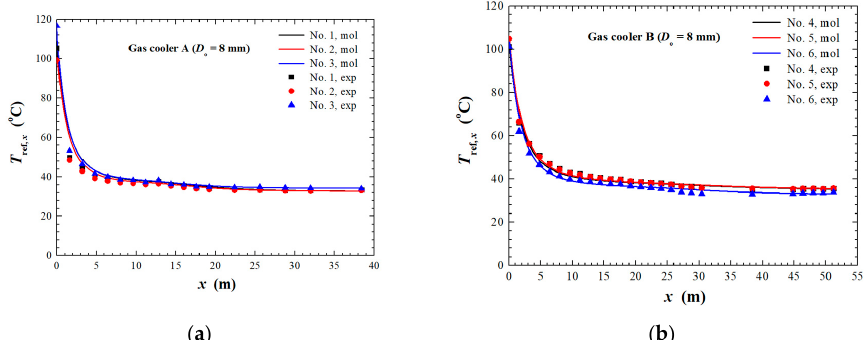
Figure 5. Comparison of the temperature profiles along the refrigerant flow direction between the modelling predictions and test results: ( a ) for the 3-row gas cooler A and ( b ) for the 2-row gas cooler B.